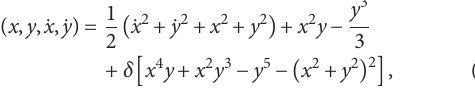
of motion have a special appearance and form closed paths,